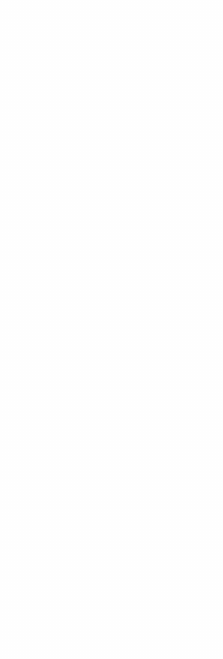
Table 1. Patient characteristics and lung function parameters at entry in the study, according to treatment group Characteristic